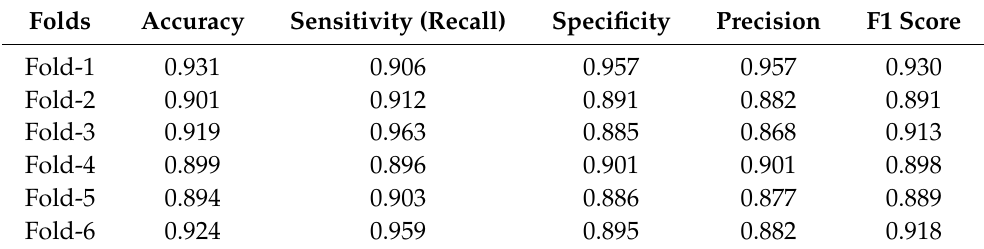
Table 5. The evaluation metrics of the proposed model (VGG16 with attention) for ALL classification. Folds